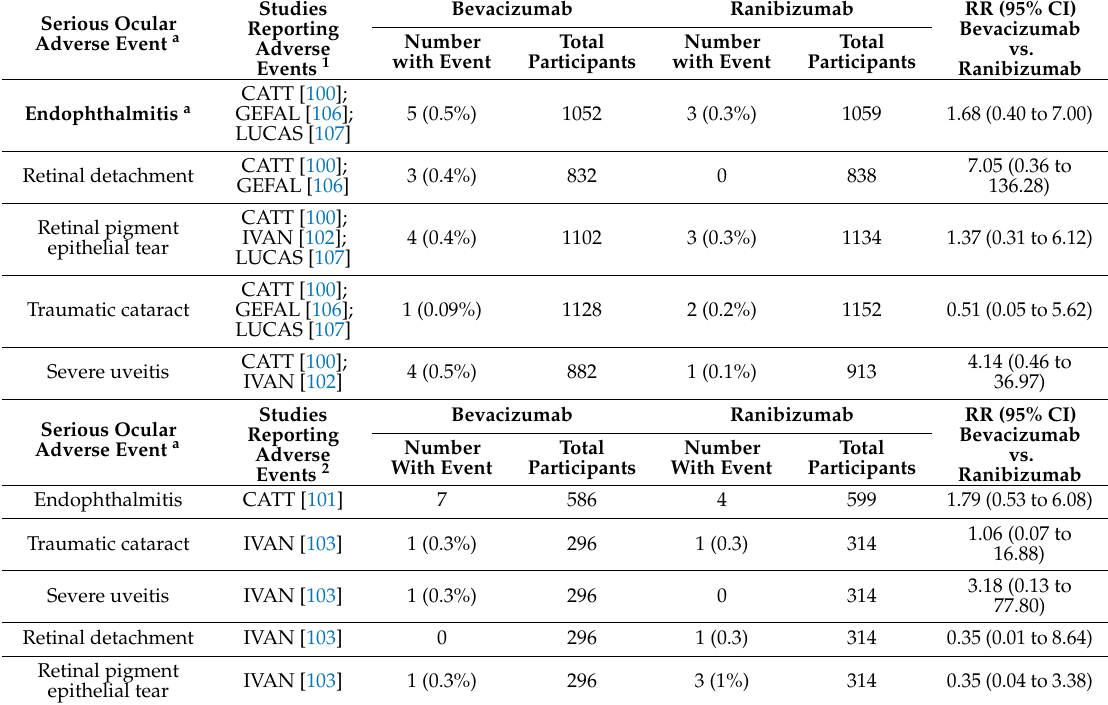
Table 4. An overview of the ocular adverse events reported by age-related macular degeneration patients treated with bevacizumab. Adapted from Solomon et al.